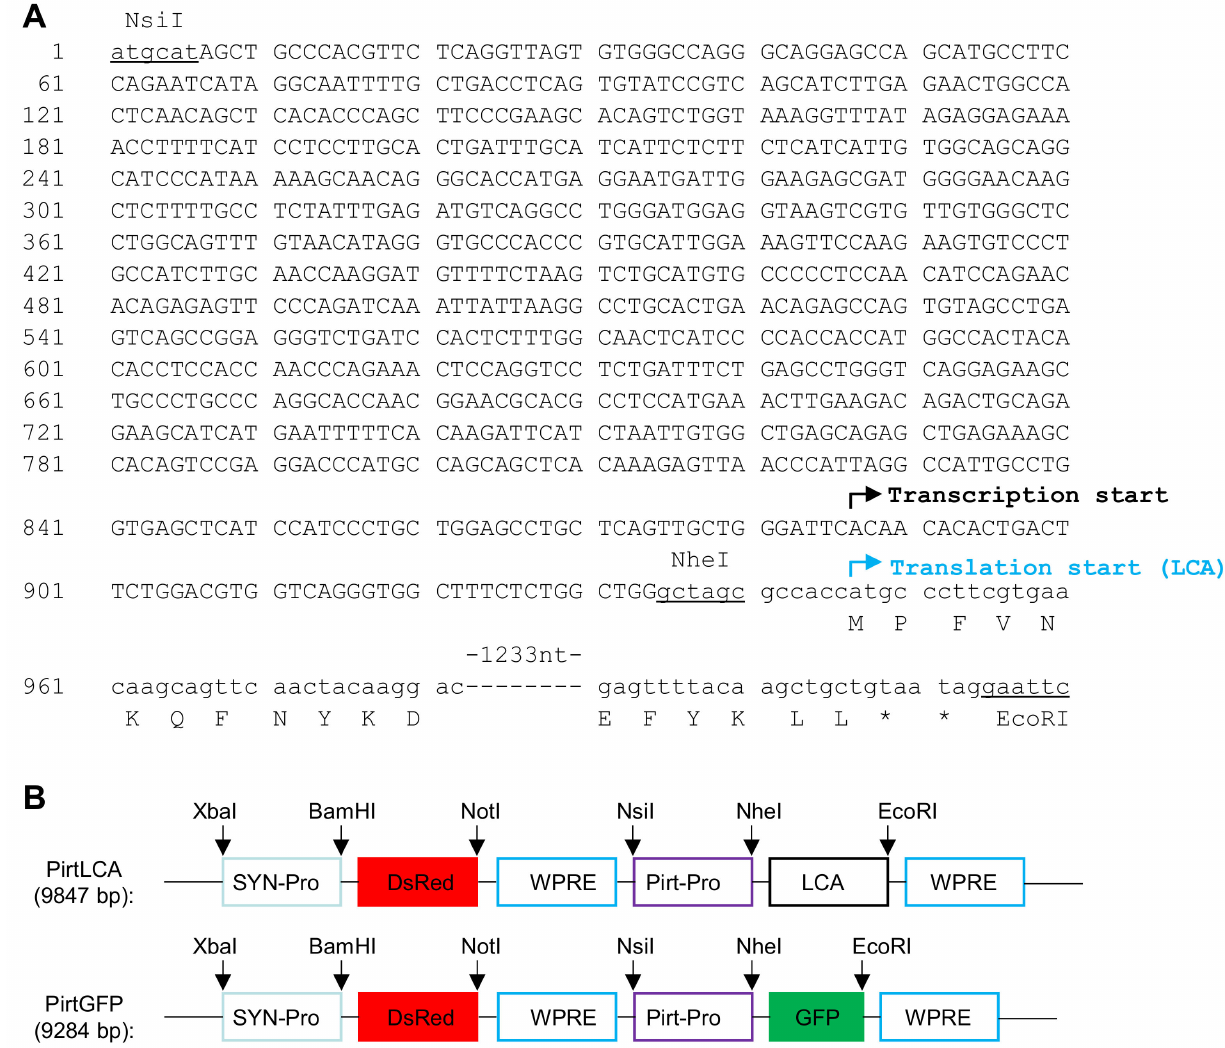
Figure 1. Illustration of the engineered lentiviral transfer vectors. ( A ) Nucleotide sequence of PirtLCA expression cassette. Pirt promoter nucleotides are depicted in capital letters. Underlined nucleotides are engineered restriction enzyme recognition sequences for cloning. The predicated transcription start site and LCA translation initiation site are indicated. ( B ) Restriction map of PirtLCA and PirtGFP transfer vectors. The critical restriction sites are indicated with arrows. DsRed and GFP are referred to the two reporter